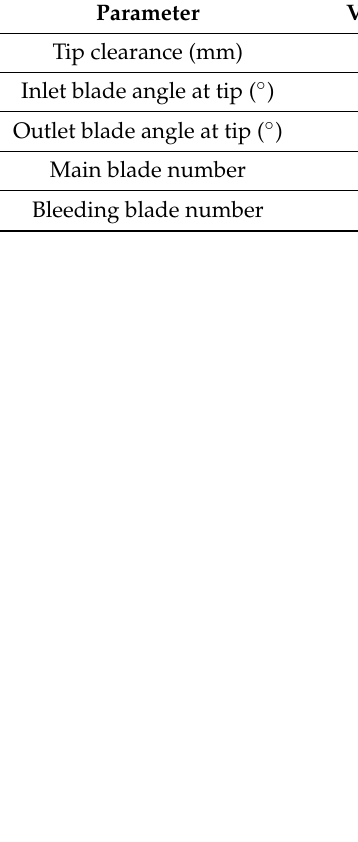
Table 2. Main geometric parameters.